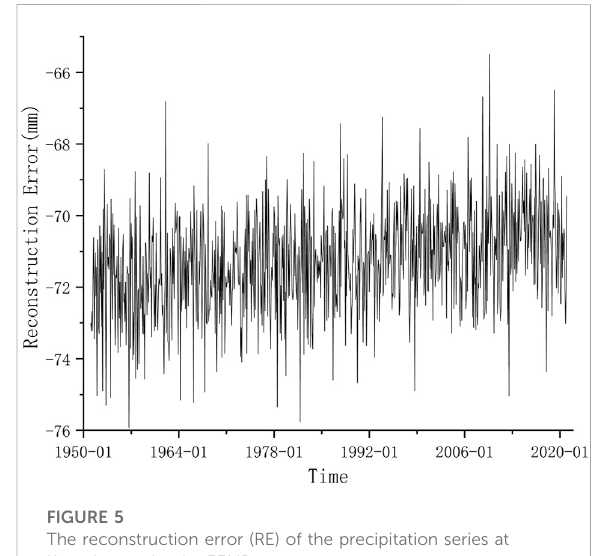
FIGURE 5 The reconstruction error (RE) of the precipitation series at Kunming station by EEMD.